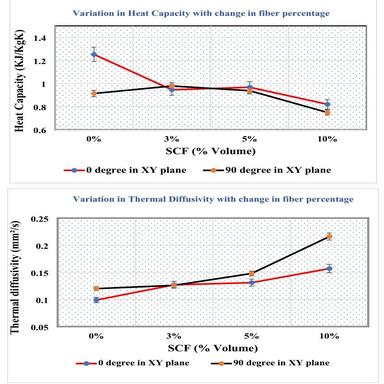
Variation in (a) heat capacity (b) thermal diffusivity of the SCF/PC composite with change in fiber content.